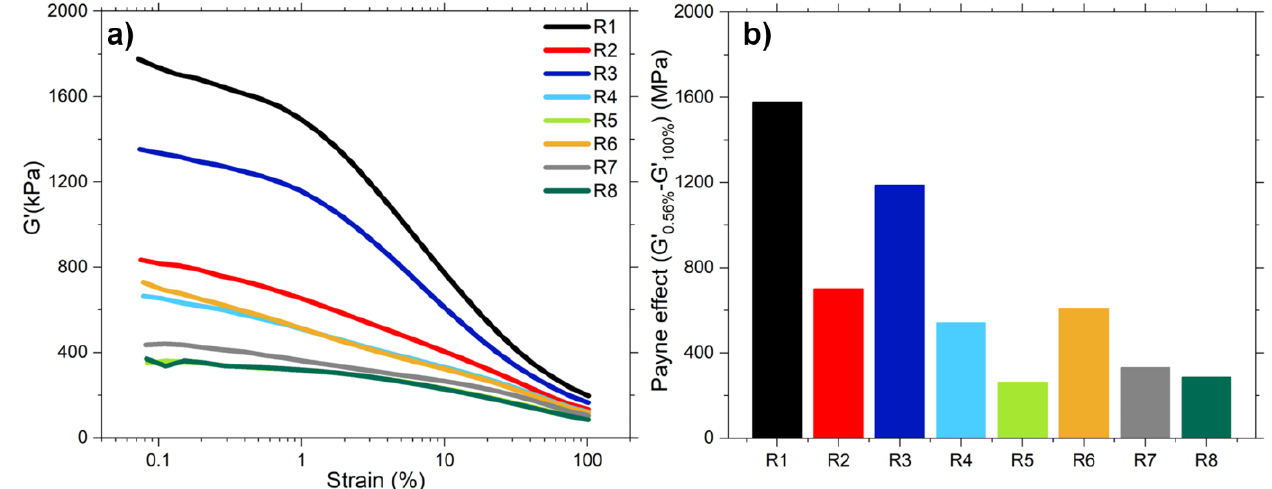
Figure 4. ( a ) Uncured Payne effect and ( b ) Δ G’ of the studied samples.